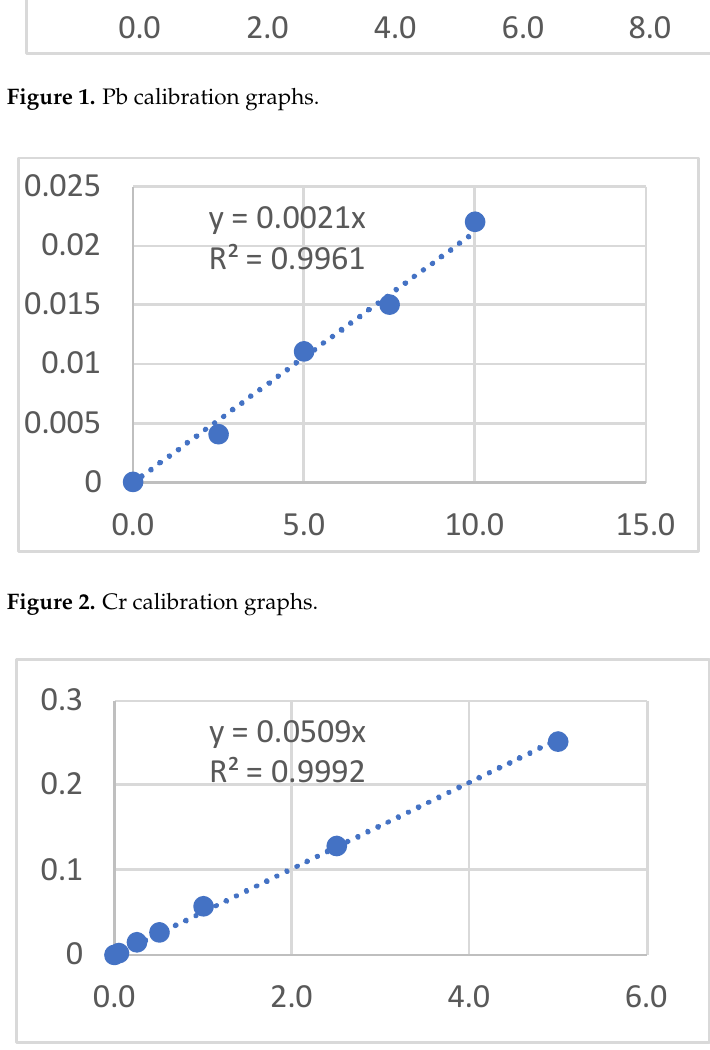
Figure 3. Mg calibration graphs